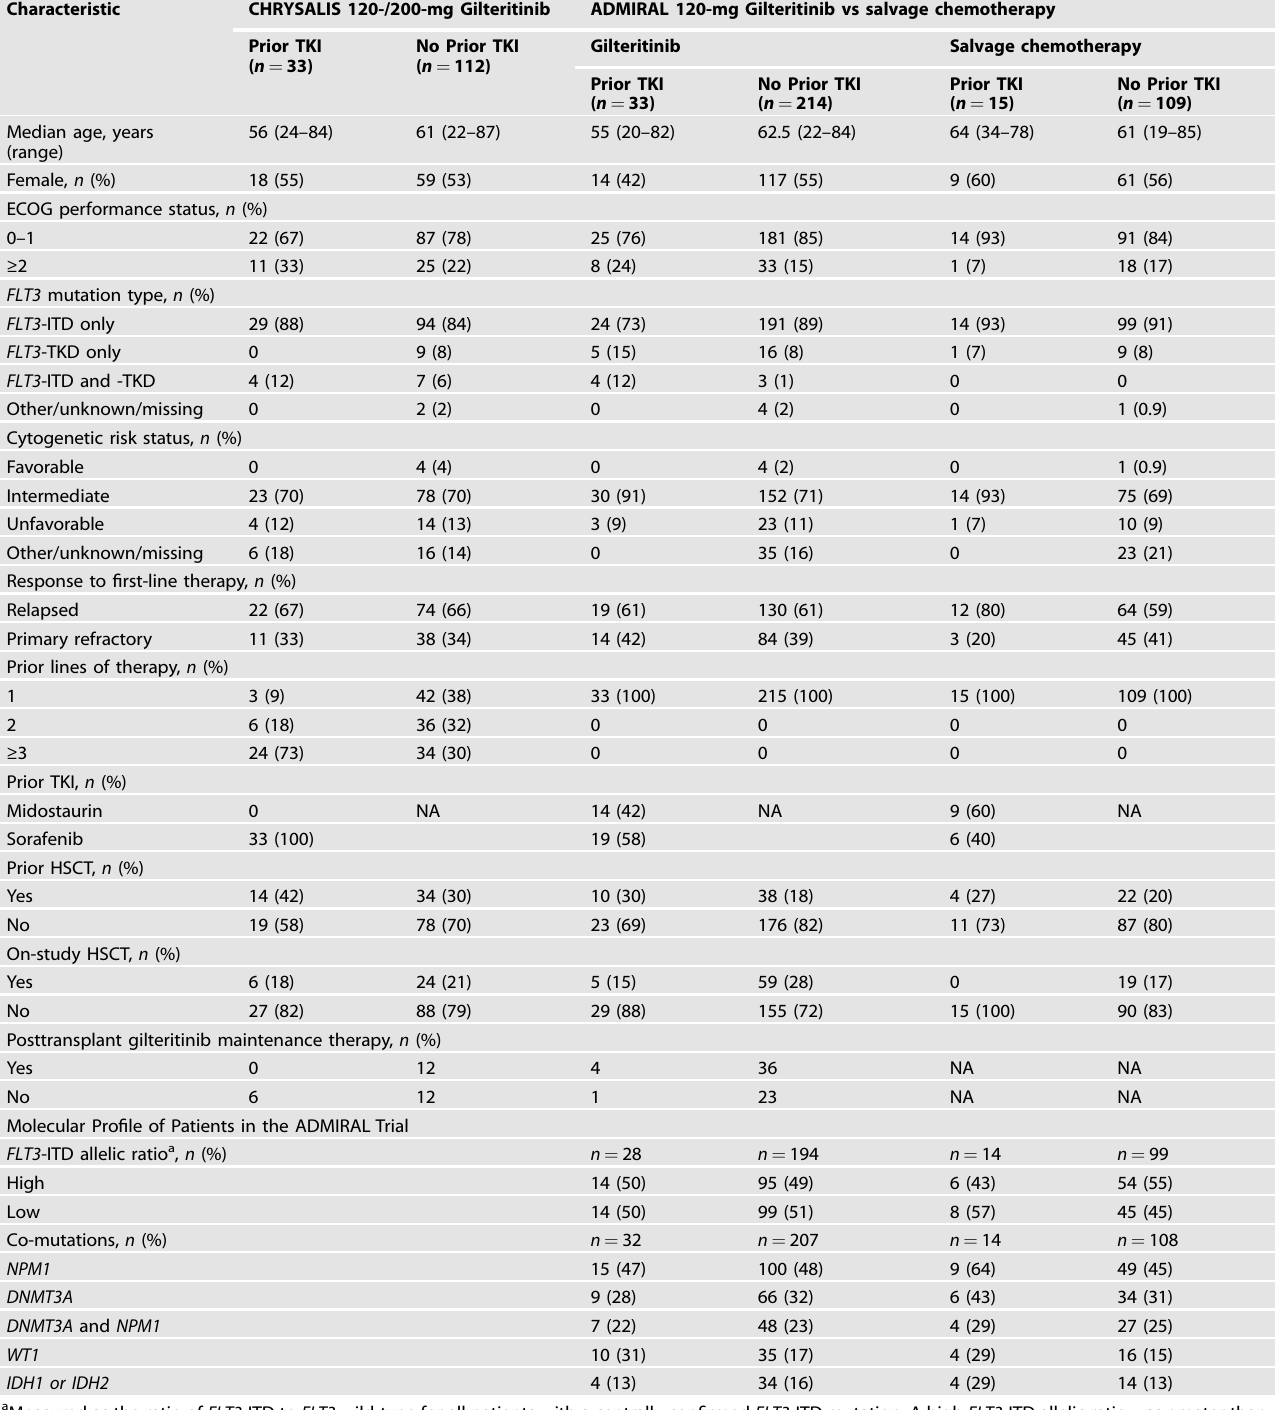
Table 1. Baseline and Prior Treatment Characteristics of Patients With R/R AML in the CHRYSALIS and ADMIRAL Trials.